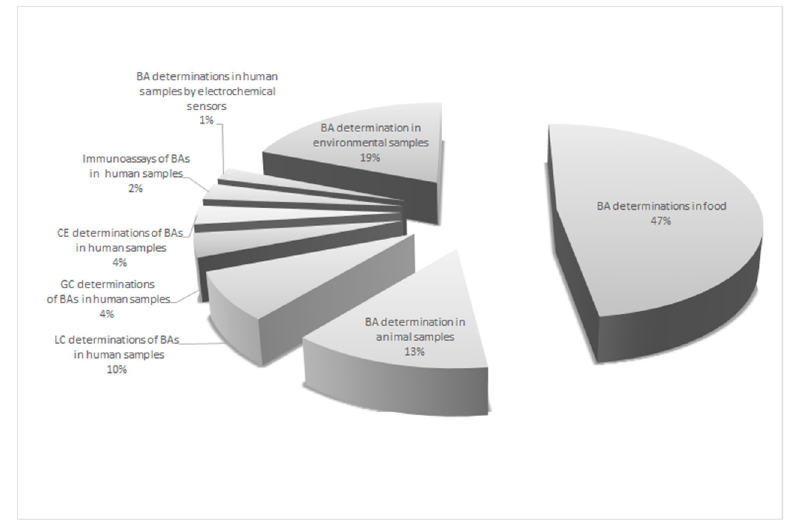
Figure 3. The distribution of the publications describing the methods for the quantification of biogenic amines (BAs) in various matrices.